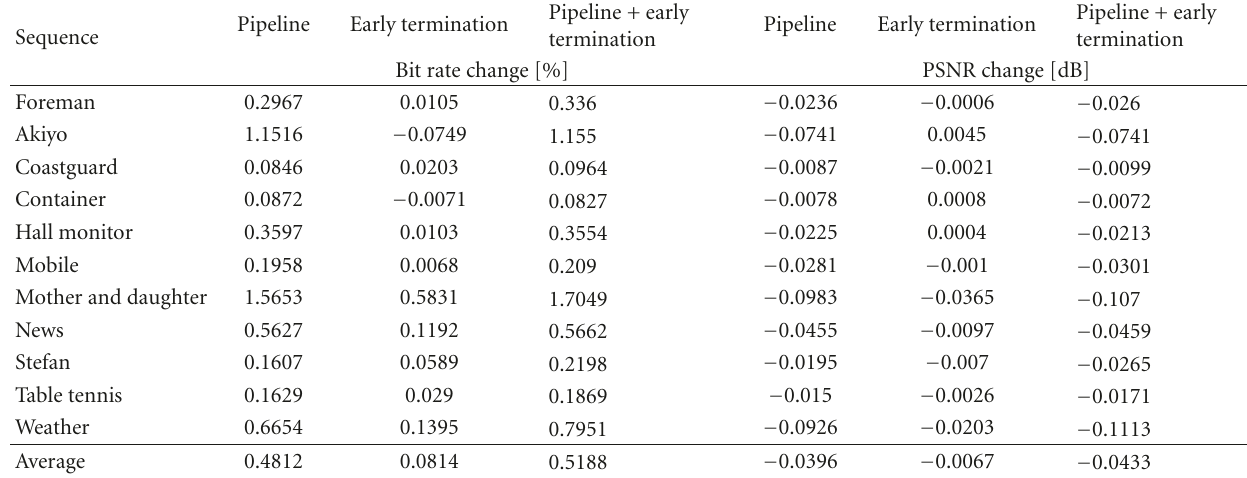
Table 6: Bit rate and PSNR change by pipeline and early termination in I slices.